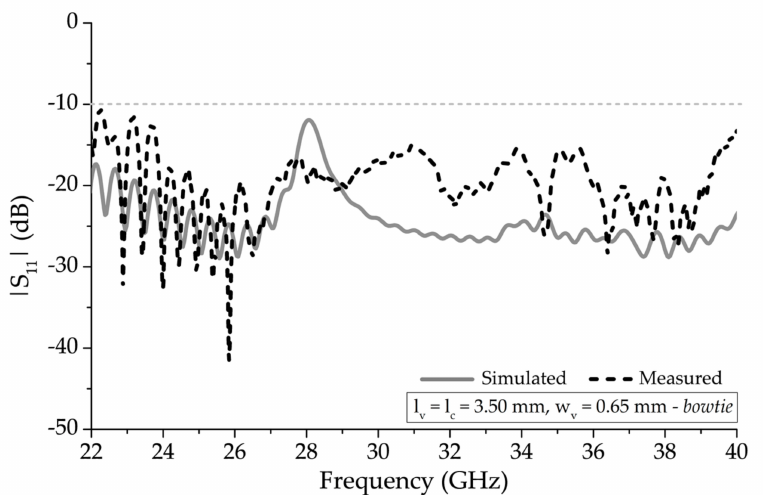
Figure 8. Simulated and measured | S 11 | of 13 unit-cell element periodic structure with bowtie vertical unit-cell segments.